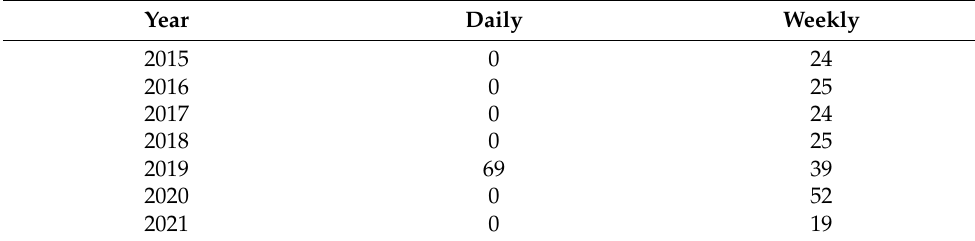
Table 2. Number of bulletins in the INGV